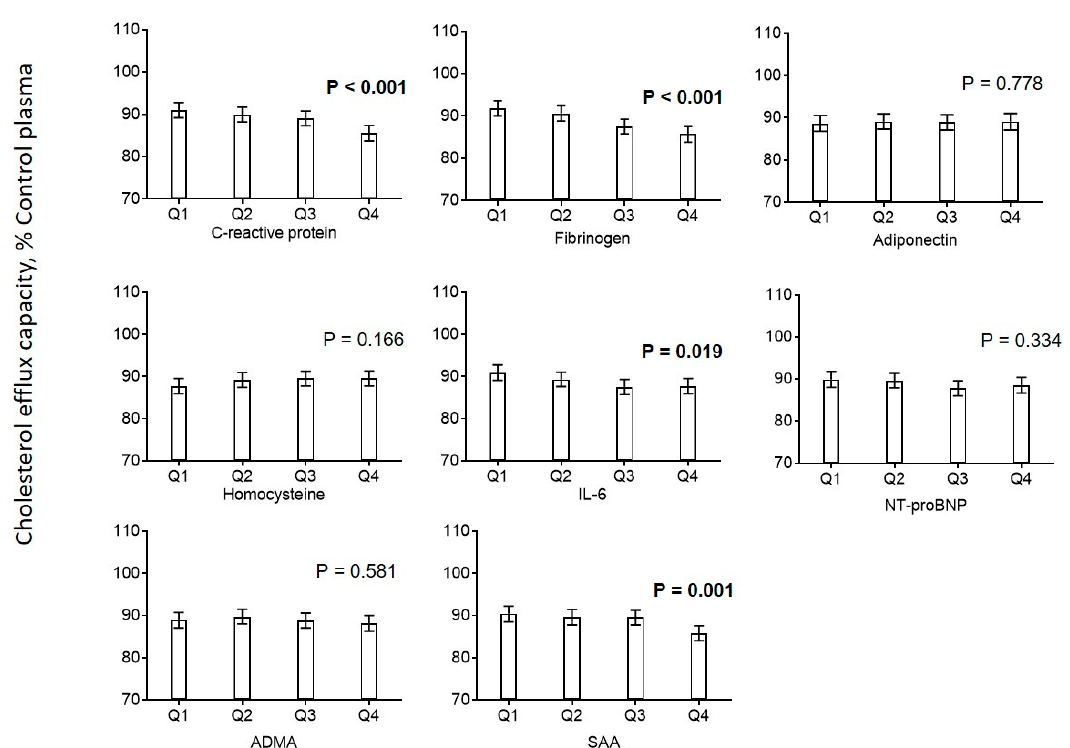
Figure 3. Association of markers of inflammation with cholesterol efflux. Diagrams show estimated marginal means with 95% confidence intervals obtained from a general linear model adjusted for use of statins, age, CAD, diabetes mellitus, smoking, LDL cholesterol, HDL cholesterol, and triglycerides. Age, LDL cholesterol, HDL cholesterol, and triglycerides (log-transformed) were included as continuous rather than categorical covariables. p values are given for comparison with the first category of each variable. p values < 0.05 are shown in bold